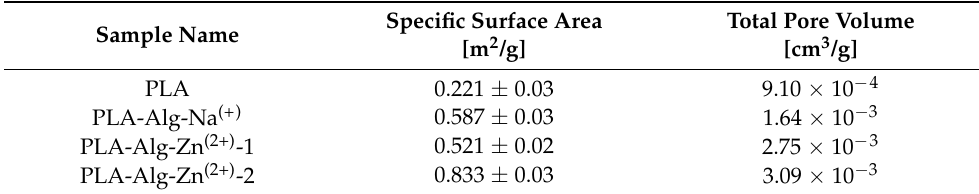
Table 4. The specific surface area and total pore volume for unmodified PLA nonwoven and PLA- ALG-Zn (2+)